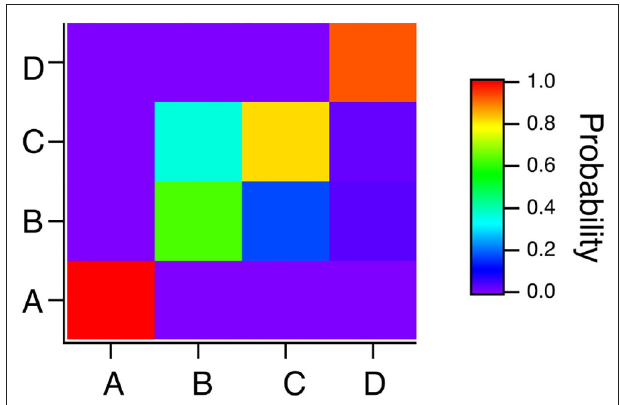
FIGURE 7 | Confusion matrix for identifying the four Sprott systems A,B,C and D with the spiking reservoir computer when γ = 0.004, R τ = 36 and T C = 15. Along the x axis are the actual Sprott systems, while the y axis shows the probability that the Sprott system will be identified as that particular